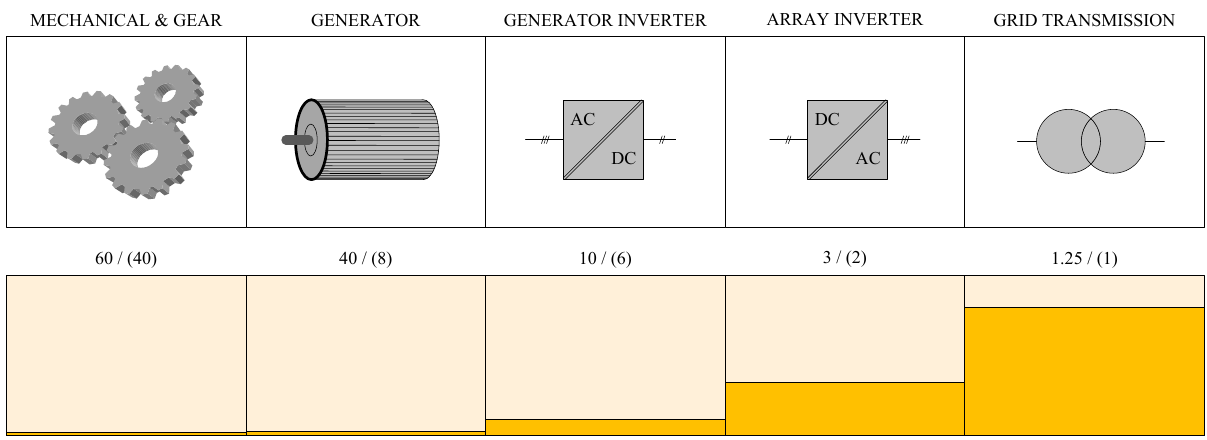
Figure 3. Illustration of the improved power quality through the power transfer chain. The power quality is given as the peak-to-average ratio and illustrated with orange bars. The nominal oversize factor is denoted with parentheses ( i.e ., the name plate rating on the generator divided by the average produced